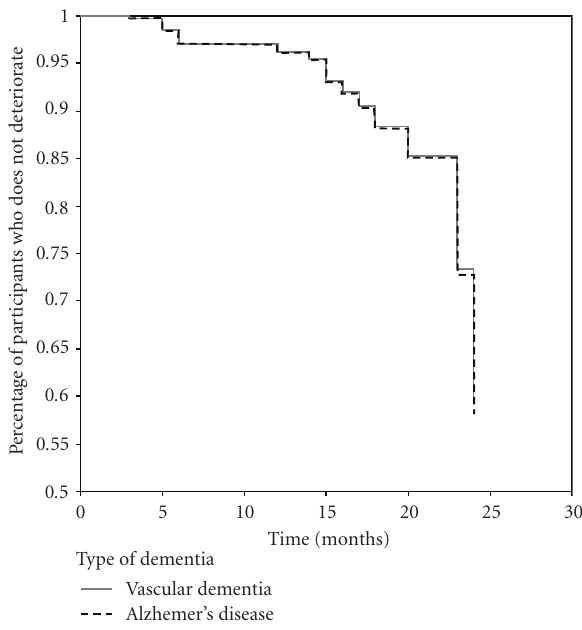
Figure 1: Survival Rate in Relation to Severity of Dementia (CDR scale): without vascular risk factor in the model.